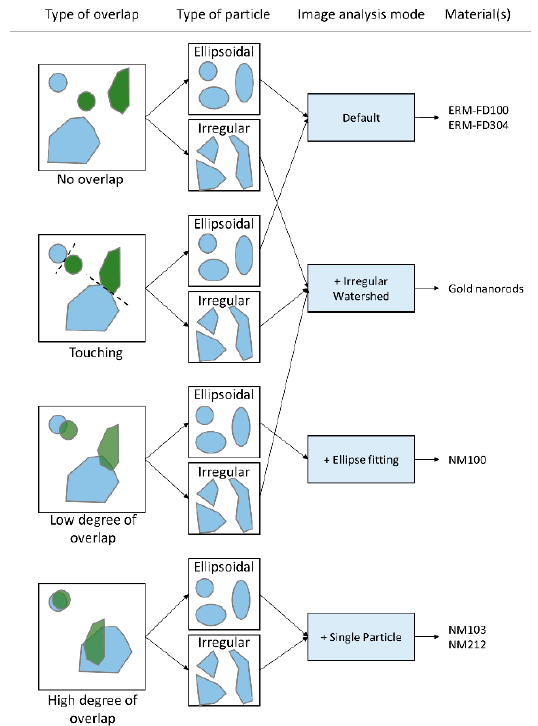
Figure 1. Schematic representation of image analysis by the Particlesizer software. The preferred image analysis modes for the materials selected for the validation study are indicated.